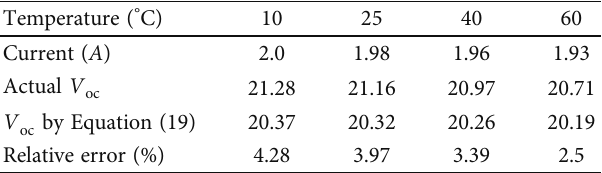
Table 4: Estimation of the PV module open-circuit